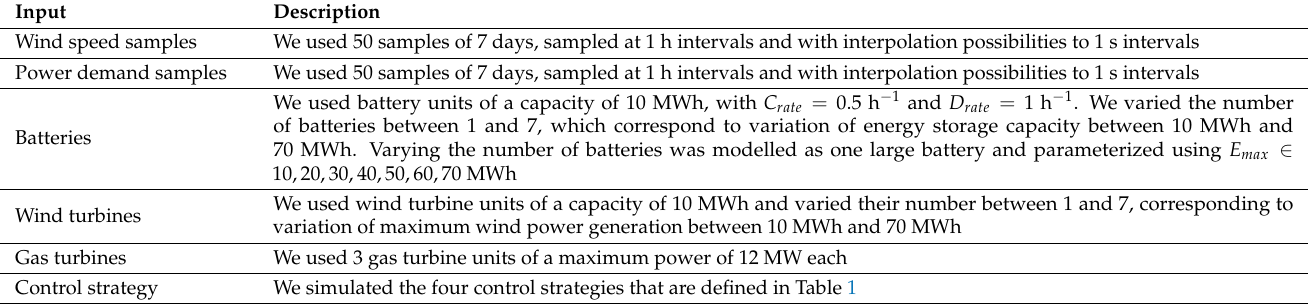
Table 2. Overview of the simulation parameters.